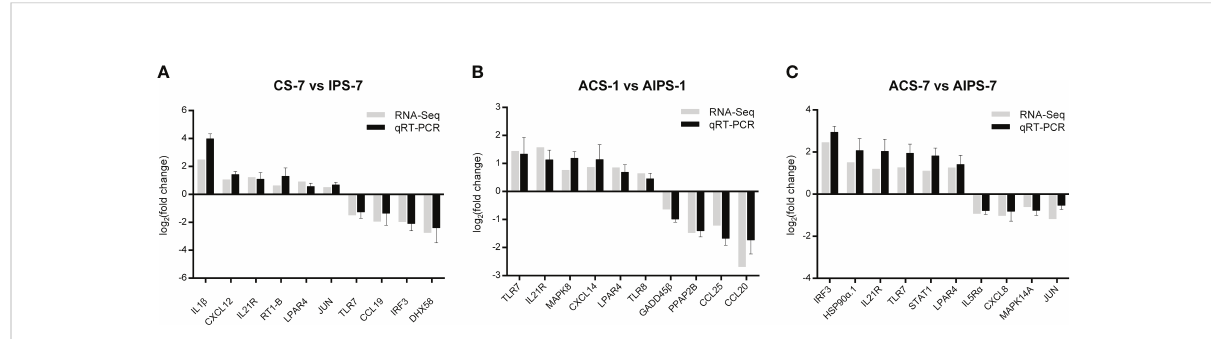
FIGURE 11 Comparison of gene expression levels between quantitative real-time polymerase chain reaction (qRT-PCR) and transcriptome sequencing at 7 th post immunization day (A) and 1 st (B) and 7 th (C) post challenge